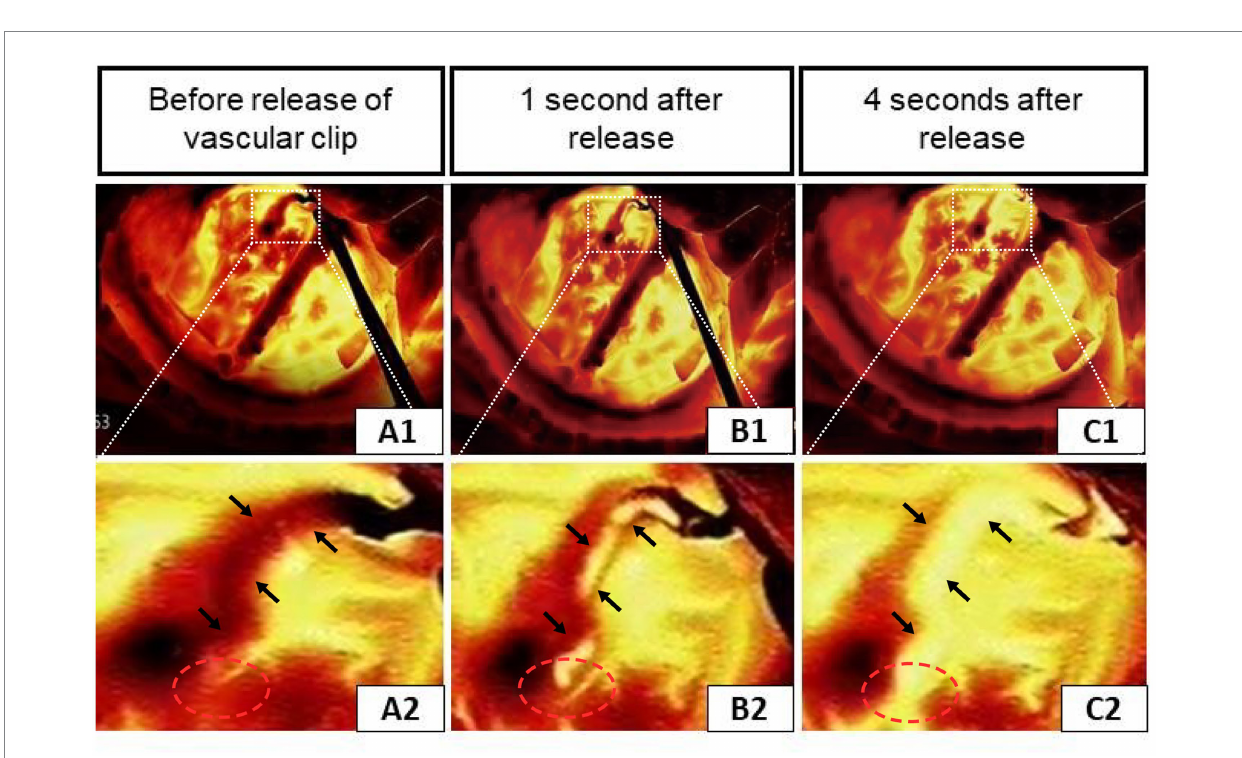
FIGURE 2 Infrared thermography of a case during right STA-middle cerebral artery (M4) bypass surgery. (A1–C1) Infrared thermographic images of the vessel clip before and shortly after release. (A2–C2) Enlarged views correspond to the upper (the black arrows indicate the STA and the red circles show the anastomosis of the donor and recipient vessels).